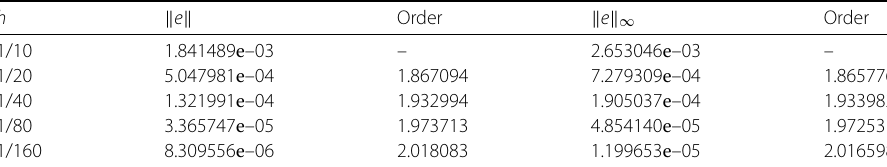
Table 2 Error and convergence order in space when τ = 1/1000, (cid:4) = α = β = γ = 1